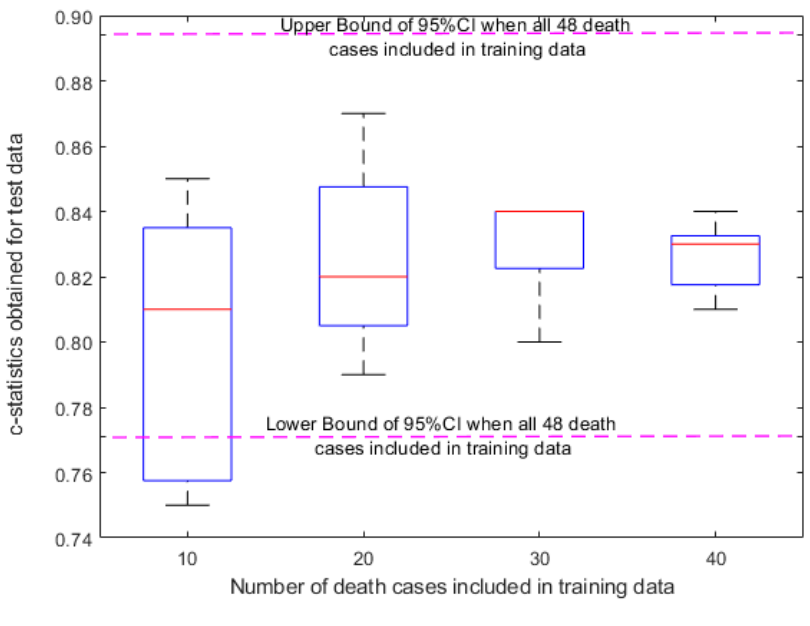
Figure 4. Sensitivity analysis for QPM Figure 4 . Sensitivity analysis for QPM model.